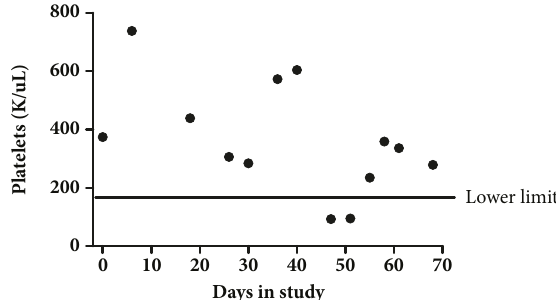
Figure 5: Platelet counts over time. Temporary thrombocytopenia was reported from day 4 to 8 after the third treatment. The effect wastransientandthepatient’slowplateletsresolvedwithoutmedical intervention on day 12 after the third